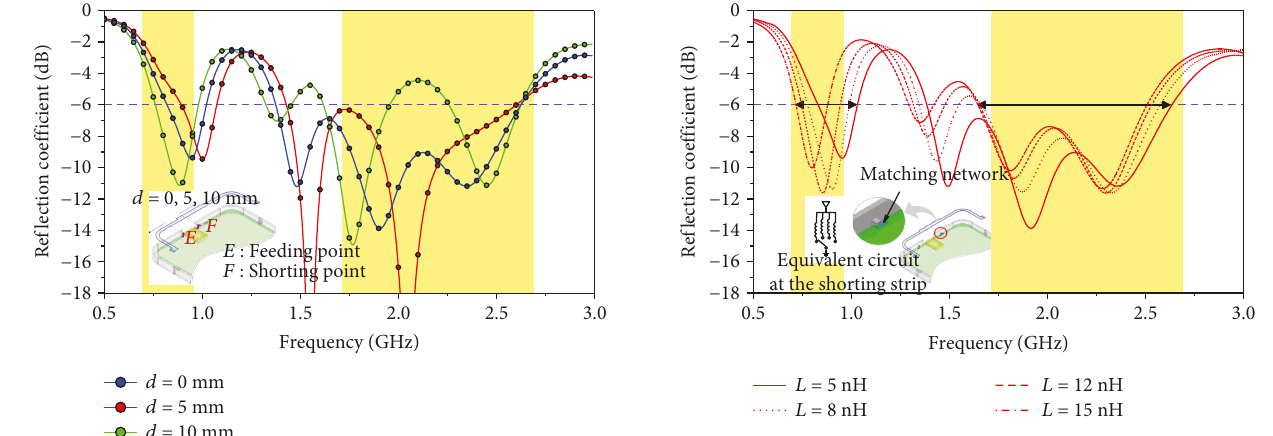
Figure 5: Re fl ection coefficient of the proposed antenna as a function of the feed and short point position ( d ).